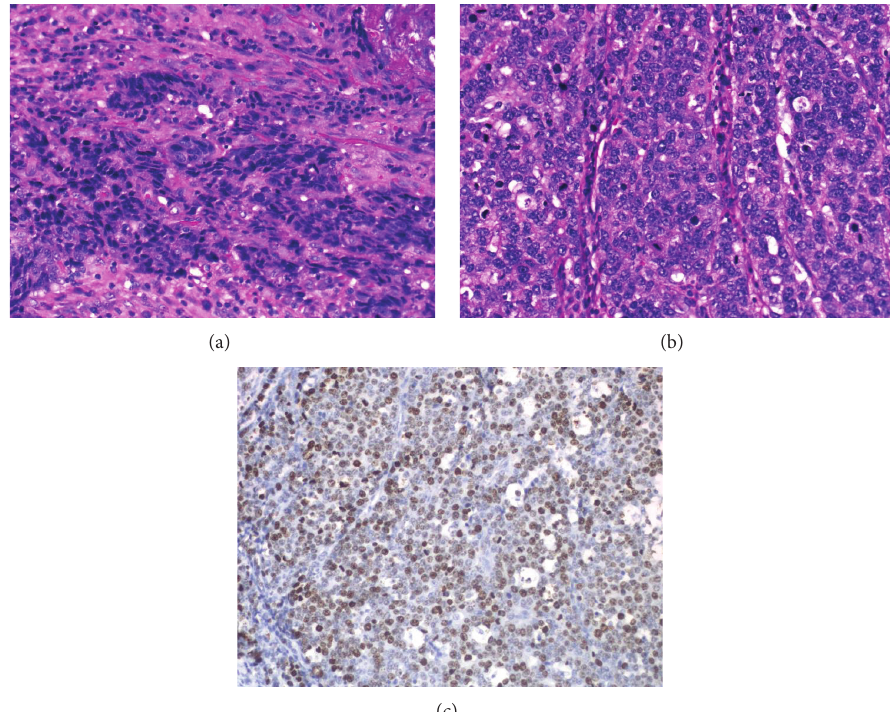
Figure 4: Microscopic examination of the resected specimen revealed the mixture of small (a) and large cells (b). Immunostaining by Ki-67 antibody revealed 58% of positive cells (c).